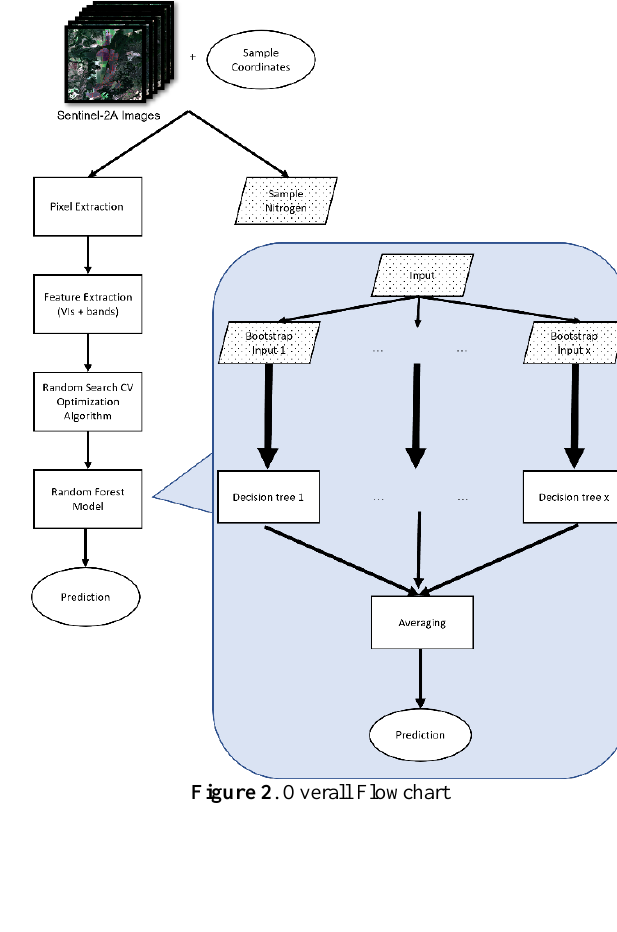
Figure 2 . Overall